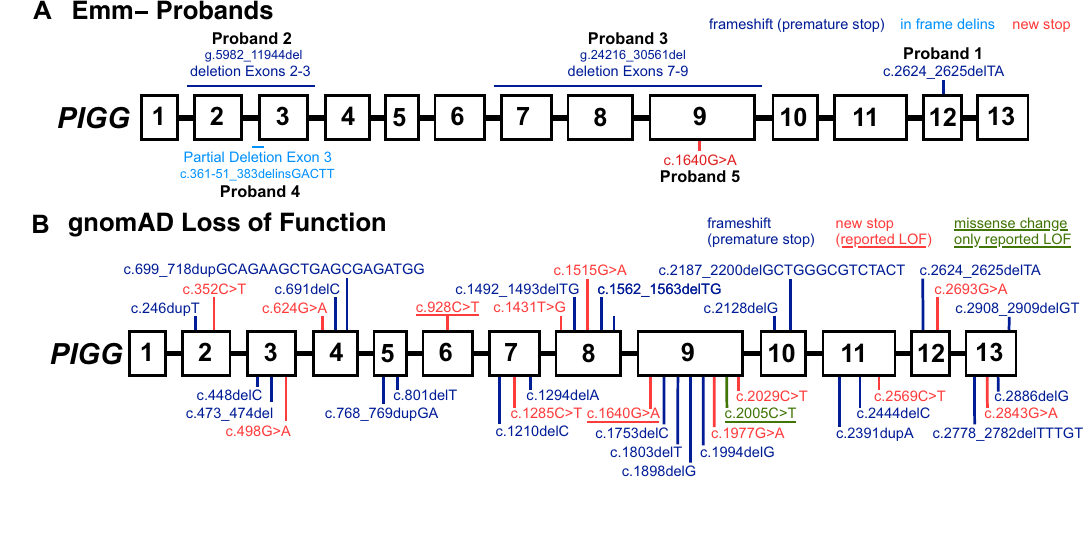
Figure 4. PIGG loss of function variants. ( A ) The five loss of function variants reported or investigated here are shown. Three causes a frameshift and premature stop codon, one causes a deletion and insertion, and one introduces a stop codon. ( B ) PIGG loss of function variants found in gnomAD cause frameshift and premature stop codons (blue) or directly introduce a stop (red). Previously reported loss of function variants associated with neurologic phenotypes are shown underlined, including variants that alter splicing (purple) and missense variants (green).